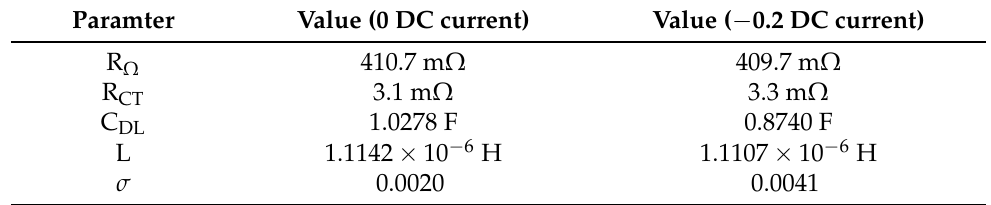
Table 3. Estimated parameters (proposed